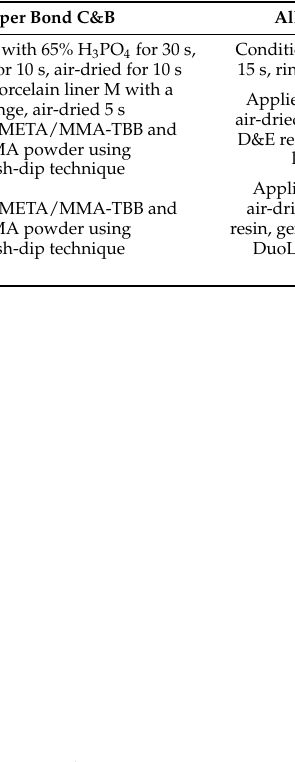
Figure 2. Tensile loading using a universal testing